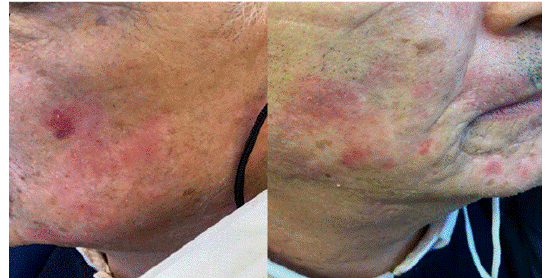
Figure 7. Erythematous annular patches in malar and chin areas in a patient with previous history of cutaneous lupus erythematous.